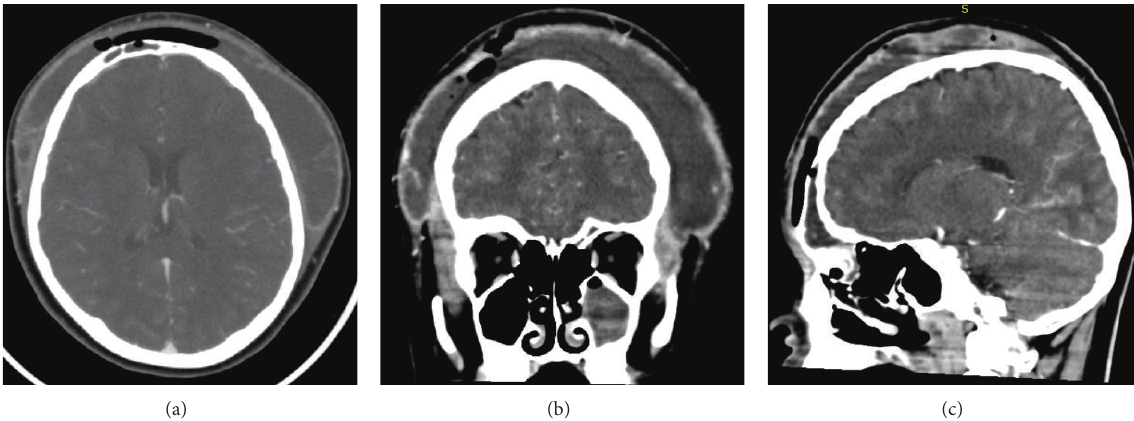
Figure 1: Axial (a), coronal (b), and sagittal (c) CT without contrast demonstrating soft tissue swelling of the forehead and parietal region; erosion of anterior table of the frontal sinus; frontal, maxillary, and anterior ethmoid sinuses opacification; subcutaneous emphysema.